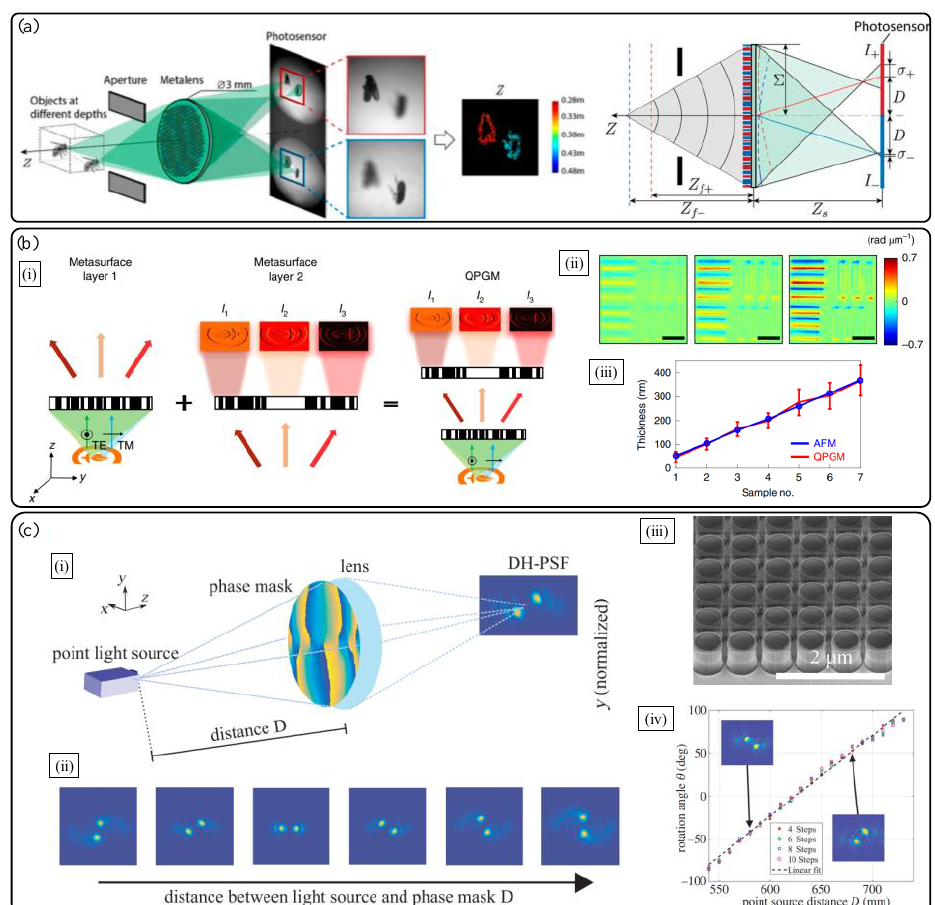
Figure 8. Other single-shot 3D sensing technologies with dielectric metalenses. ( a ) Single multiplexed metalens depth sensor inspired from eye structure of jumping spider [36]. ( b ) Monolithic doublet metalens based quantitative phase microscopy [38]. ( i ) Schematic diagram and ( ii ) phase retrieval result of a resolution target. ( iii ) Accurate depth sensing result in comparison with atomic force microscopy. ( c ) Phase mask optimized dielectric metalens depth sensor with engineered point spread function [37]. ( i ) Schematic diagram and ( ii ) working principle. ( iii ) Fabrication and ( iv ) depth sensing results. ( b ) Reprinted with permission from [38] Copyright 2019 Springer Nature. ( c ) Reprinted with permission from [37] Copyright 2019 SPIE.